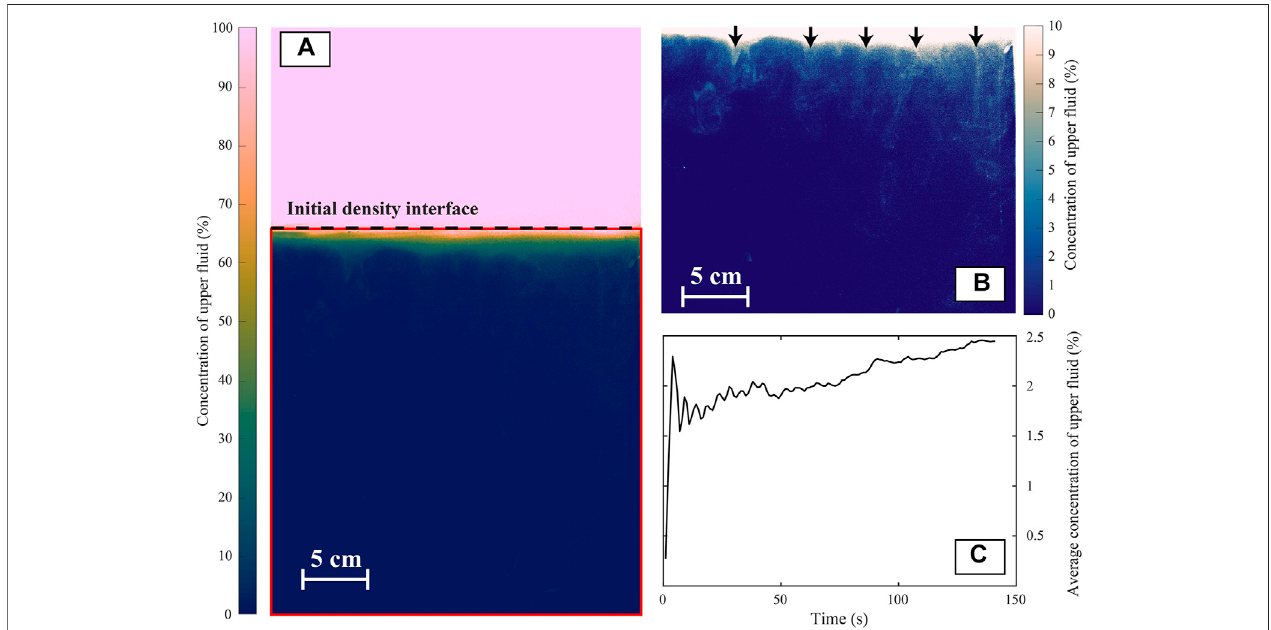
FIGURE7|(A) Spatialdistributionofupper fl uidconcentration30 safterbarrierremovalinexperiment A11(1 g l − 1 ).Theblack dashed lineindicatesthepositionof theinitialdensityinterfaceandtheredrectangletheportionoftheexperimentconsideredtobethelowerlayer. (B) Concentrationofupper fl uidinthelowerpartitionofthe tankwithanadjustedcolormaptohighlightregionsofupper fl uidentrainmentwithin fi ngers.Blackarrowsshowthelocationofleaks. (C) Averageconcentrationofupper fl uid in the lower layer. Oscillations in the signal at the beginning of the experiment are initially due to the removal of the barrier and then PBL detachment (see Supplementary Video S4 ). The uncertainty on the measurement is estimated to be 17%.